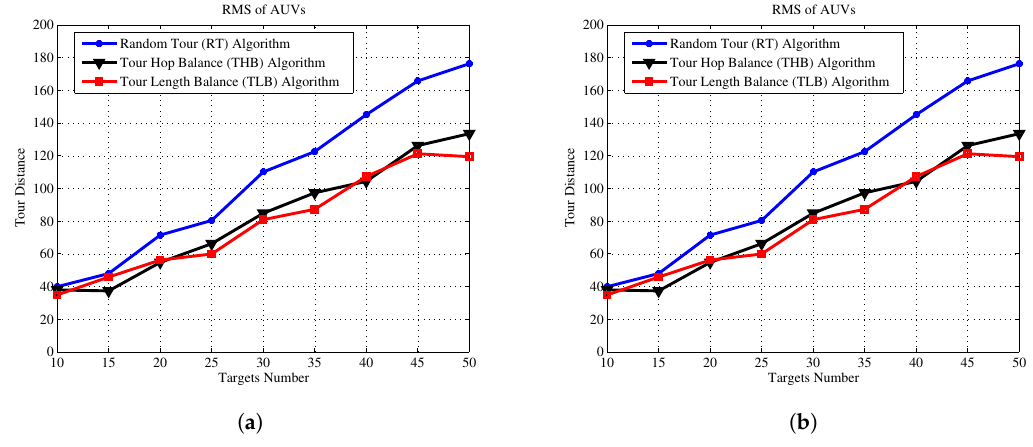
Figure 12. Energy balance comparisons. ( a ) 2 AUVs; ( b ) 4 AUVs.